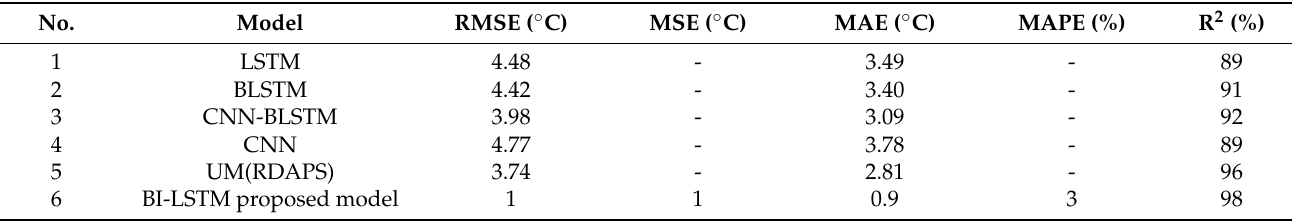
Table 5. Comparison of BI-LSTM proposed model performance with other temperature models